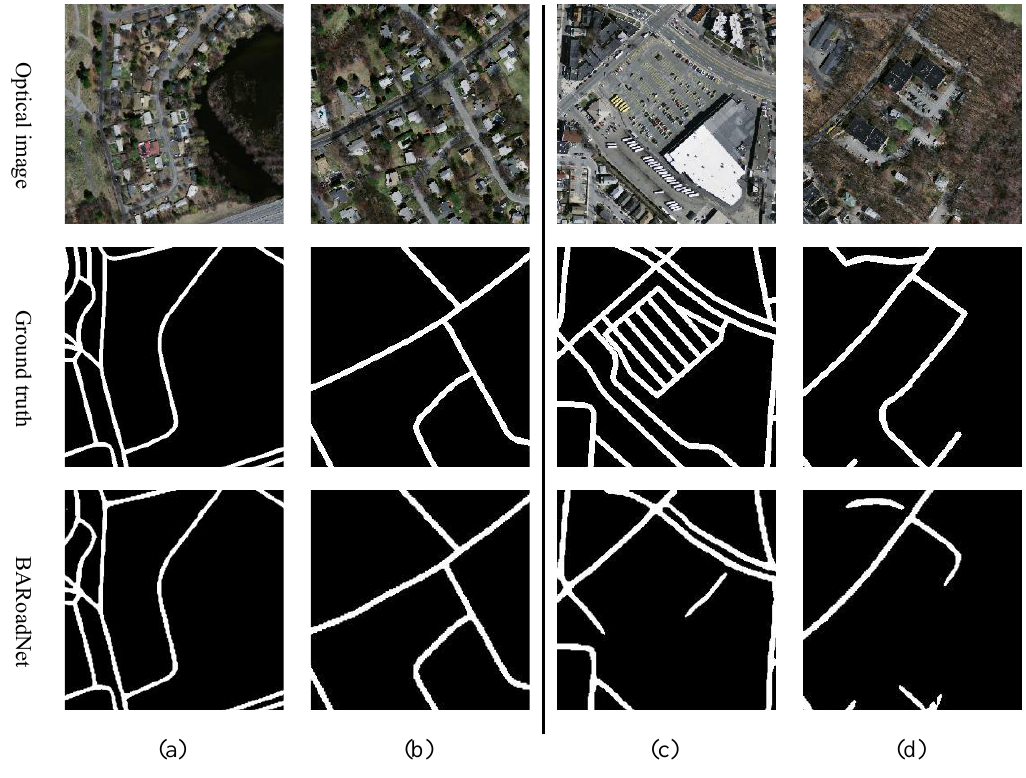
Figure 3 Close ups of red/yellow boxes marked in Figure